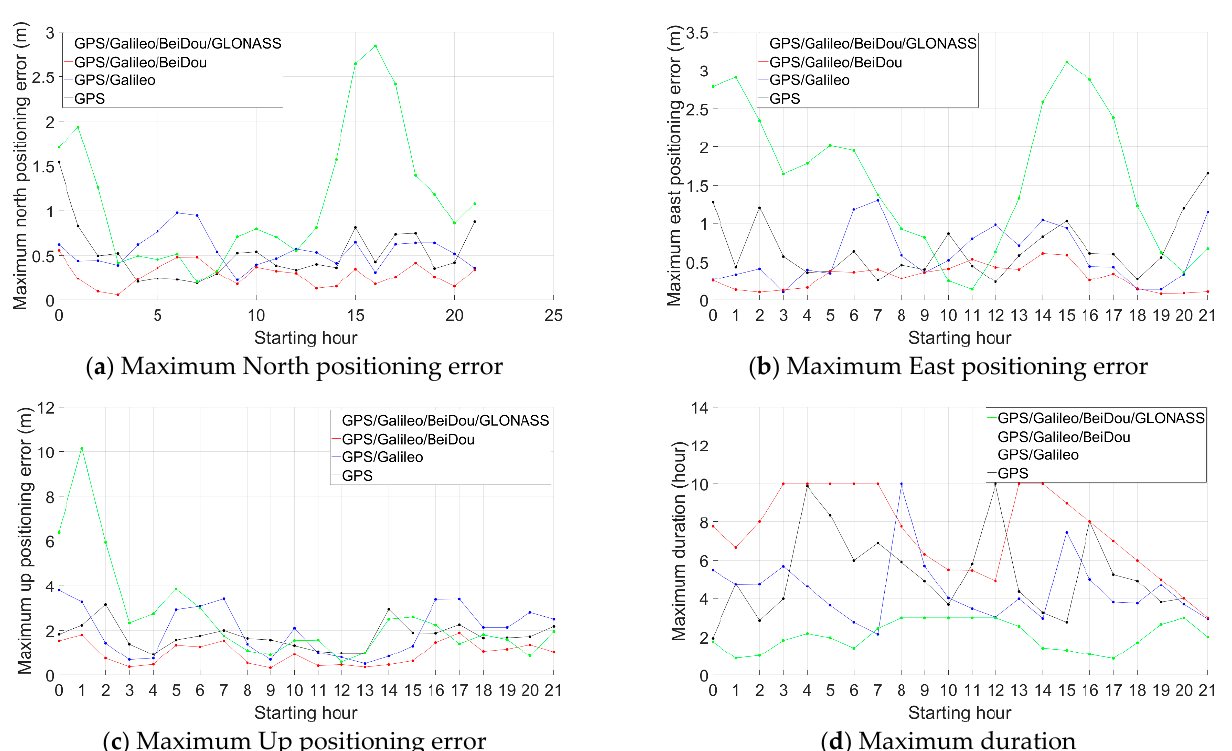
Figure 9. Maximum time-relative positioning error within 3 h ( a : north, b : east, c : up) and maximum duration with 1 m precision in both north and east directions ( d ).